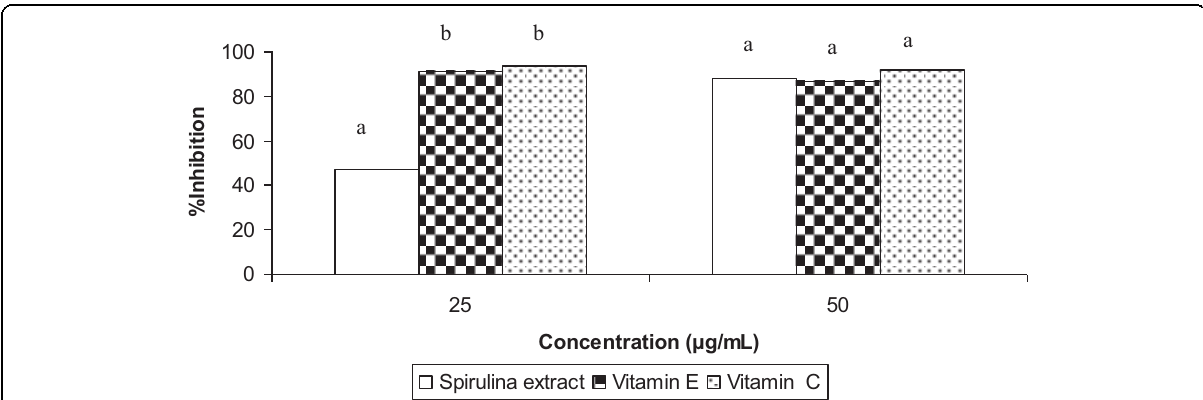
Figure 6 ABTS-scavenging activity of Spirulina extract compared with vitamin C and vitamin E at 25 and 50 μ g/mL . Data presented as mean values from three replicates; standard deviations < 1% of means. Different alphabets denote significant difference (p < 0.05) at each